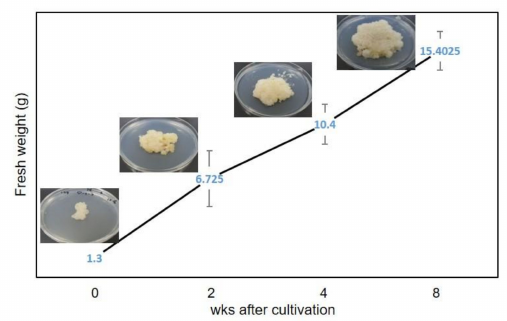
Figure 4. Fresh weight growth kinetics of S. flavescens callus (L58) cultures for 8 weeks. Values represent means ± standard error from